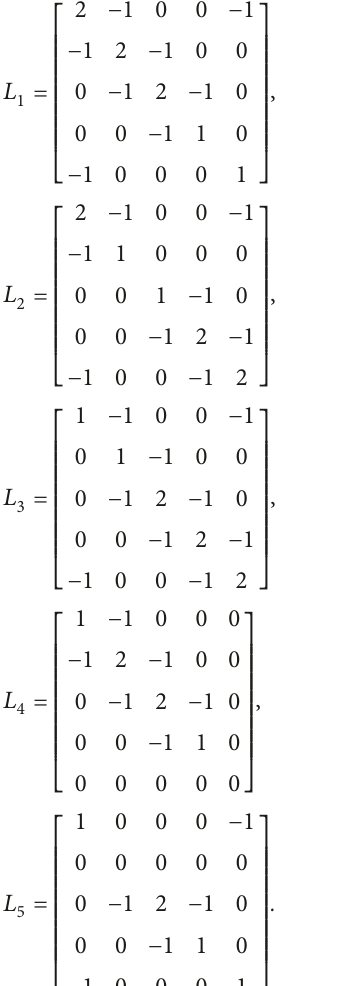
Figure 2: State for each